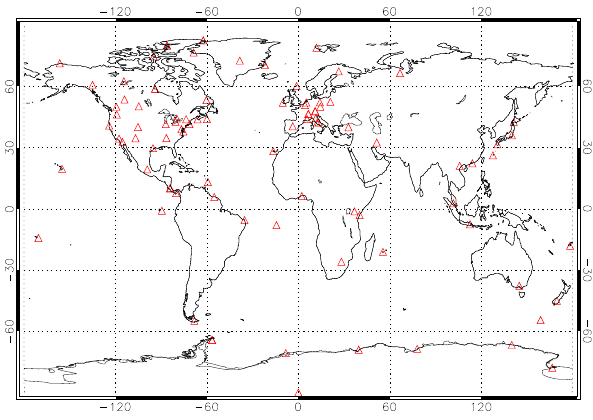
Fig. 1. Spatial distribution of the ozonesonde stations used to con- struct the dataset to train and test the